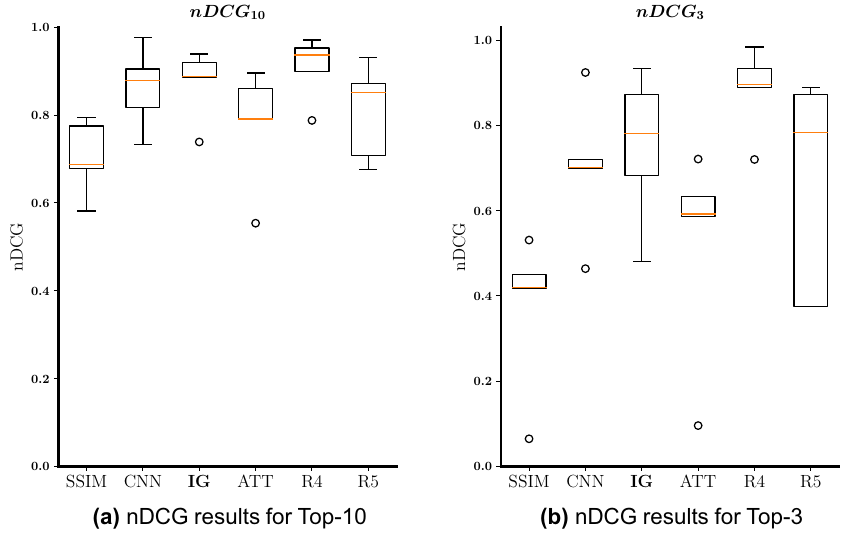
Figure 7. Box-and-whisker plots regarding the nDCG results for (potential) pneumonia Top-10 ( a ) and Top-3 ( b ) retrieved images. SSIM is the statistically-based baseline, CNN is the CNN-based baseline, IG is the proposed interpretability-guided approach, ATT is the attention method, R4 is the ranking provided by the fourth board-certified radiologist, and R5 is the ranking provided by the fifth board-certified